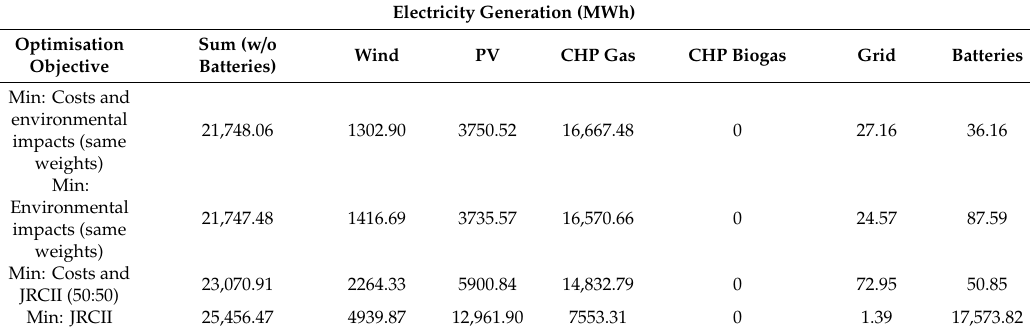
Table A4. Total electricity generation by technology for di ff erent multi-criteria optimisation